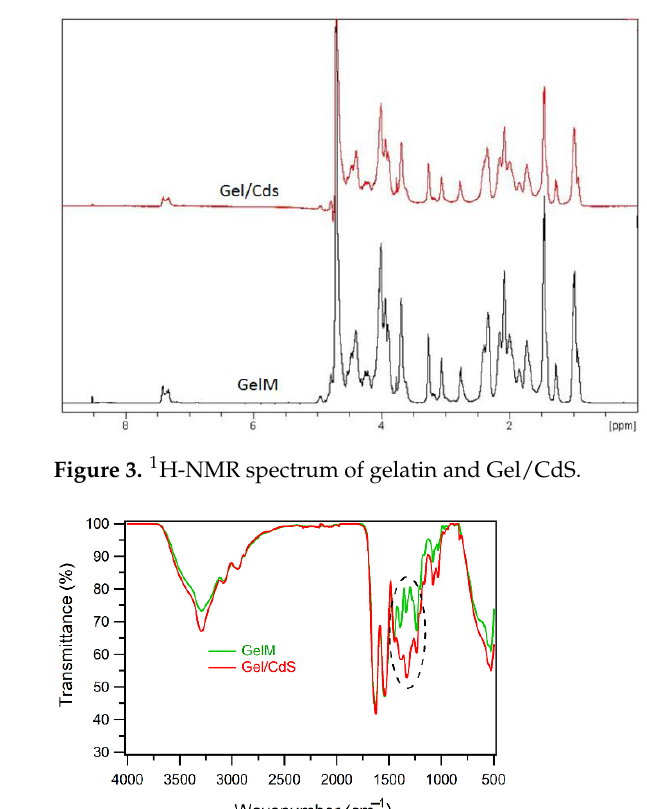
Figure 3. 1 H-NMR spectrum of gelatin and Gel/CdS.